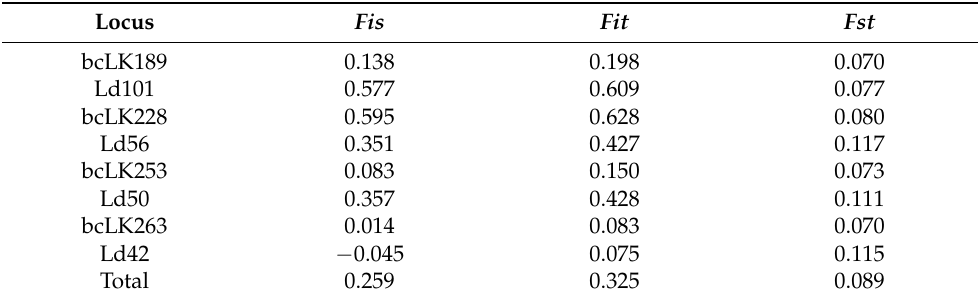
the entire population.